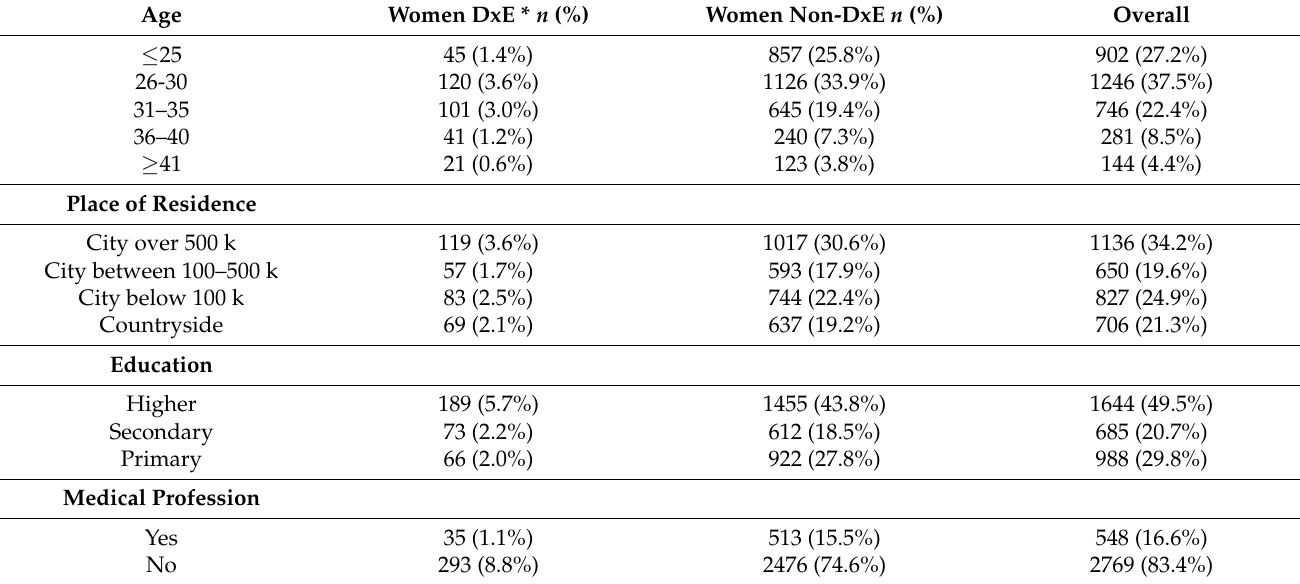
Table 1. Demographics of the study population.